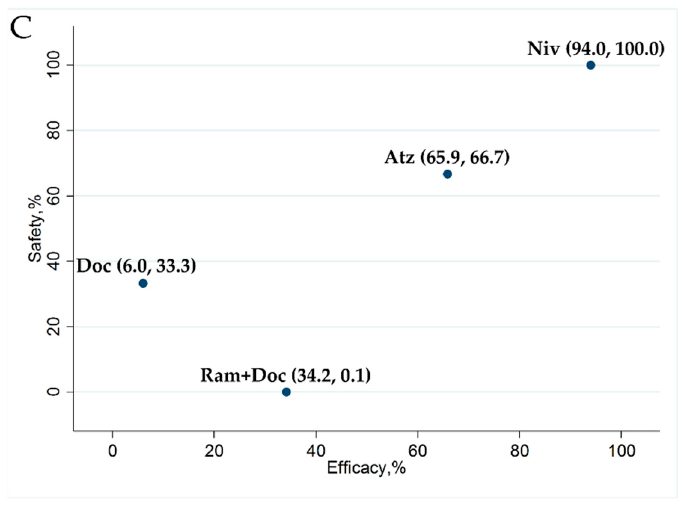
Figure 8. Scatter diagrams of SUCRAs for OS and safety in terms of G3–5AEs among Ram+Doc, Niv, Atz and Doc treatments in refractory or relapsed advanced NSCLC patients ( A ) OS in the overall population was highest following Niv treatment, followed by Atz, Ram+Doc and Doc; ( B ) In a subgroup analysis of OS in patients with non-squamous NSCLC, Atz treatment was associated with the highest OS, followed by Niv, Ram+Doc, and Doc; ( C ) In a subgroup analysis of OS in squamous NSCLC patients, Niv treatment was associated with the highest OS, followed by Atz, Ram+Doc, and Doc. Meanwhile, Niv treatment ranked the highest in terms of safety, followed by Atz, Doc, and Ram+Doc ( A – C ). SUCRA (surface under the cumulative ranking area curve); G3–5AEs (grade 3–5 treatment-related adverse events); Niv (nivolumab); Atz (atezolizumab); Ram+Doc (ramucirumab plus docetaxel); Doc